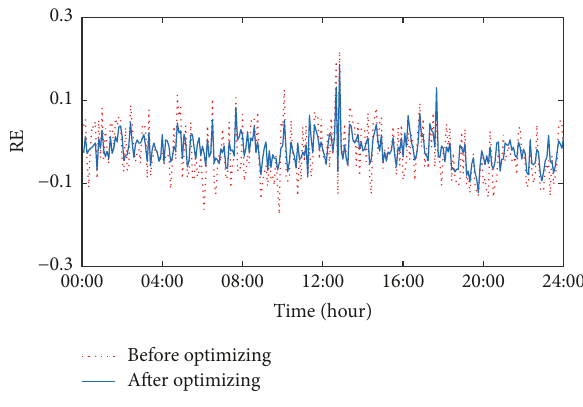
Figure 17: RE curves (03/04/2016).